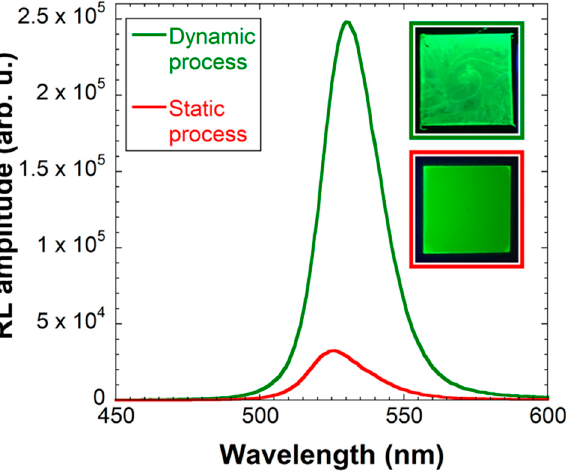
Figure 3. RL spectra of CsPbBr 3 thin films on glass prepared by using 0.6 mL of CsPbBr 3 solution in the dynamic process (green line) and by stacking 40 layers in the static process (red line). Inset: Photographs under UV illumination of the film prepared by the dynamic process (top) and static process (bottom).